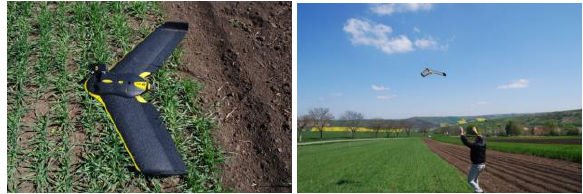
Figure 1. Photo of Sensefly eBee and its take off at experimental